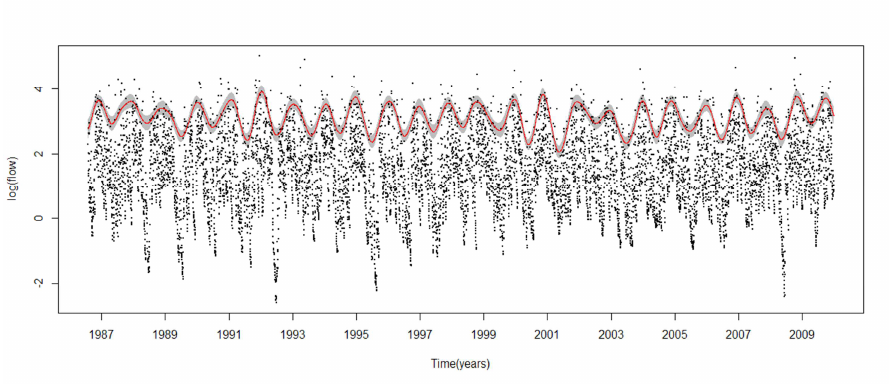
Figure 3 – 95th quantile regression for daily river flows (Franco Villoria, 2013). the observation